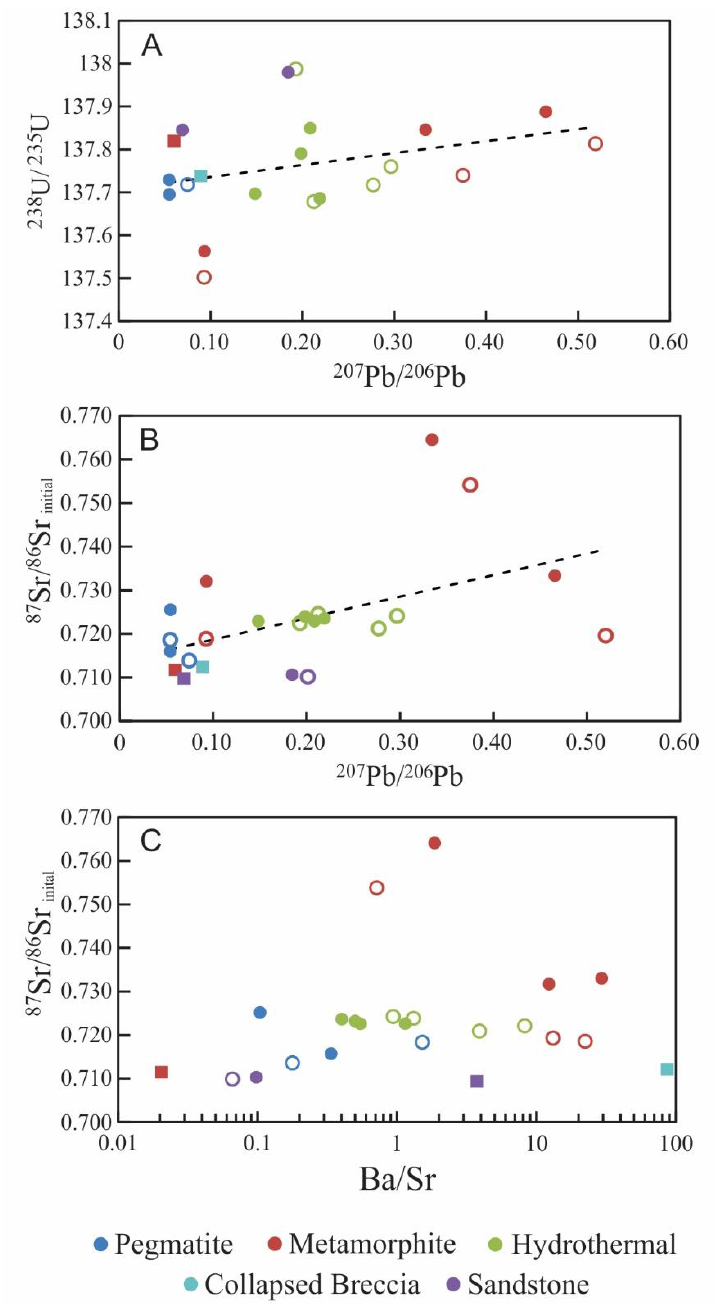
Figure 6. Isotopic and Ba / Sr signatures of uraninite from several deposit types. ( A ) 207 Pb / 206 Pb vs. 238 U / 235 U; ( B ) 207 Pb / 206 Pb vs. 87 Sr / 86 Sr; ( C ) Ba / Sr vs. 87 Sr / 86 Sr ( A – C ). Solid circles denote pristine sample, open circles represent altered fraction, and square symbols represent bulk samples where pristine and altered aliquots could not be separated.